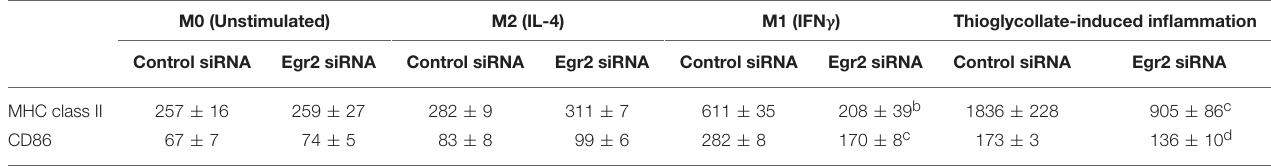
TABLE 2 | Effect of Egr2 knockdown on expression of macrophage activation markers MHC class II and CD86 during inflammatory conditions a . M0 (Unstimulated) M2